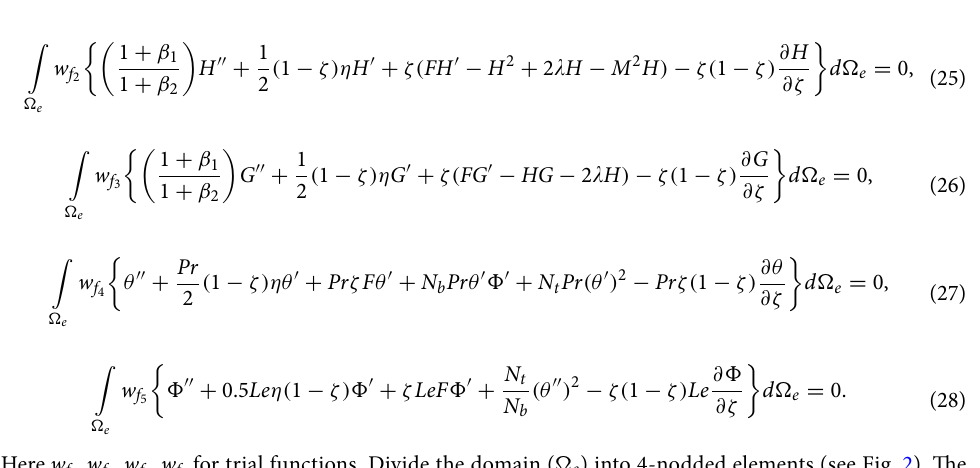
Figure 2. Rectangular